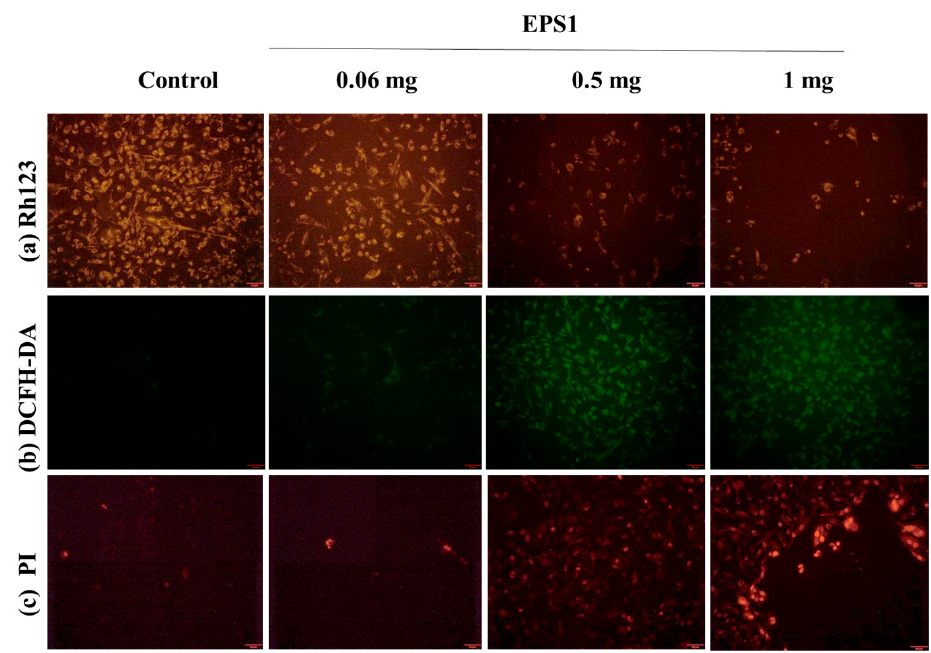
Figure 7. Effect of polysaccharides (EPS1) isolated from Trichoderma spp. on cytotoxicity in the MDA-MB231 cell line, demonstrated by fluorescent microscopic staining assay: observation of mitochondrial membrane loss ( a ), reactive oxygen production ( b ), and nucleus damage in membrane-compromised cells ( c ).